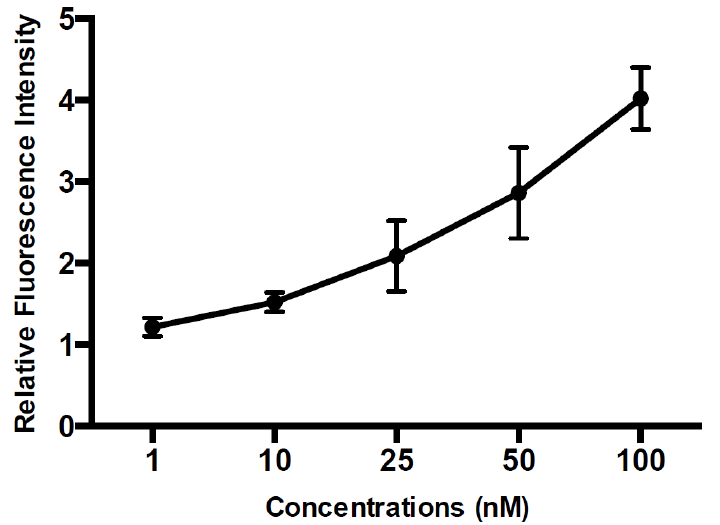
Figure 7. Measured relative fluorescence intensity according to Legionella deoxyribonucleic acid (DNA) concentrations. The relative fluorescence intensity is the ratio of the sample fluorescent intensity to that of the control.